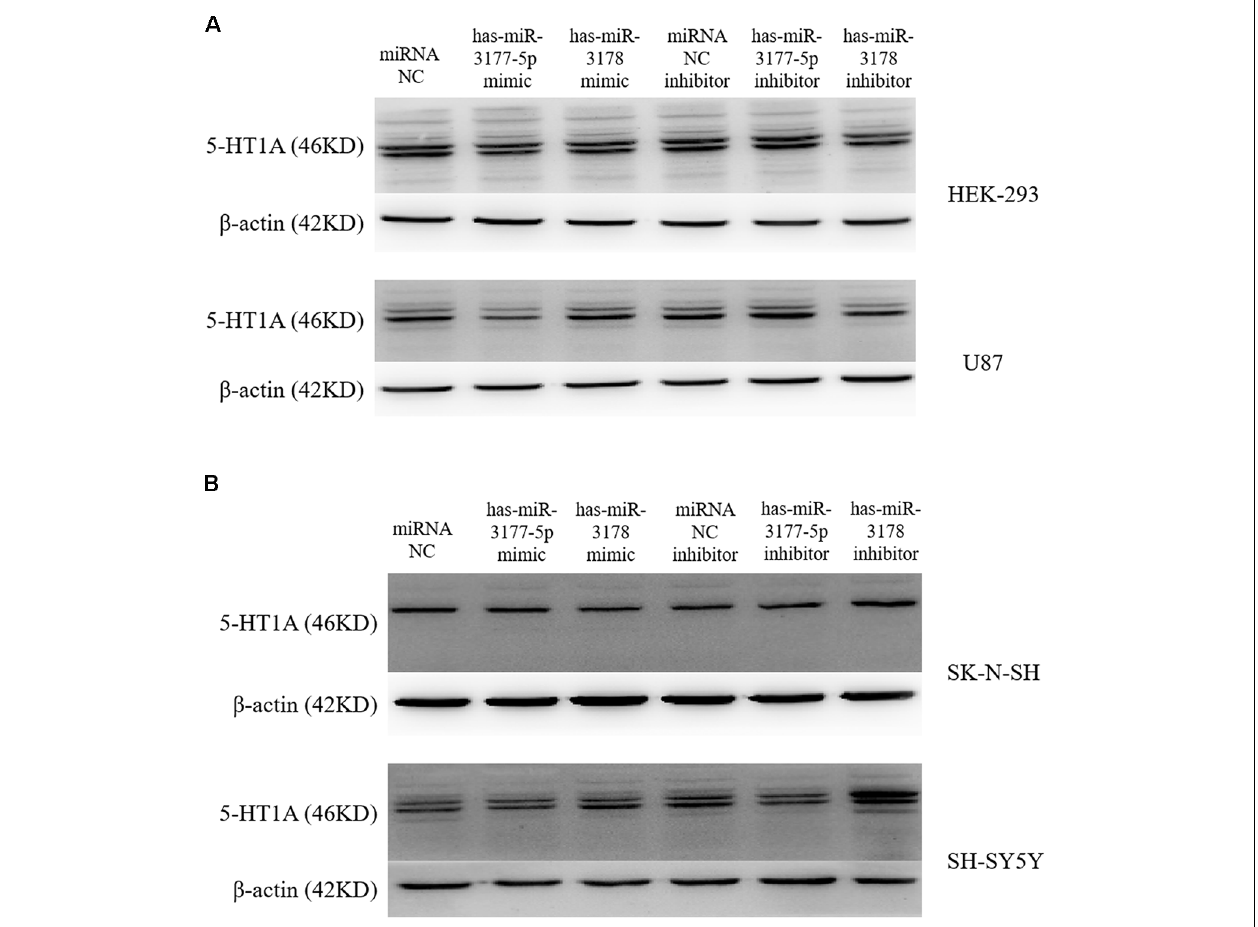
FIGURE 6 | Inhibitory effect of hsa-miR-3177-5p and hsa-miR-3178 on endogenous 5-HT1A receptors (A) . Western blot analysis showed that hsa-miR-3177-5p significantly inhibited endogenous 5-HT1A receptor expression in HEK-293 and U87 cells. Only in the U87 cells, the hsa-miR-3177-5p inhibitor slightly increased 5-HT1A receptor expression without reaching statistical significance. (B) Results showed that the hsa-miR-3178 inhibitor significantly increased endogenous 5-HT1A receptor expression in SK-N-SH and SH-SY5Y cells. However, in SK-N-SH cells, hsa-miR-3177-5p and hsa-miR-3178 mimics might down-regulate 5-HT1A expression. Beta-actin is shown as the internal reference